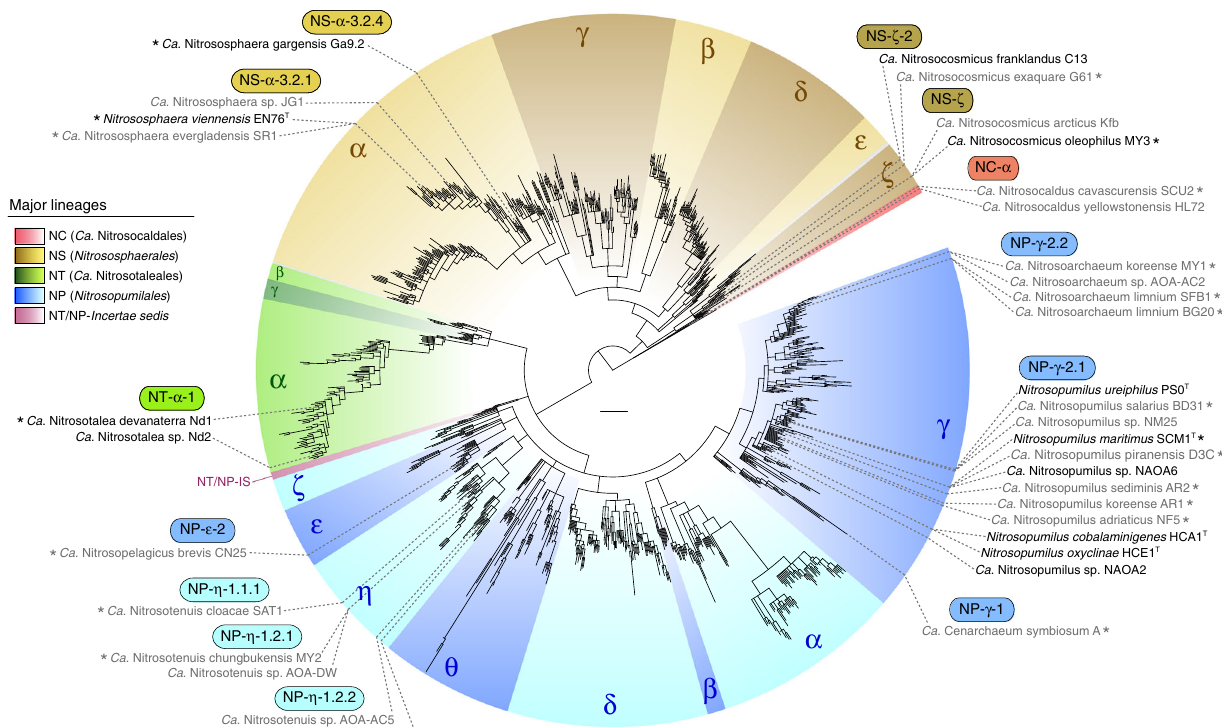
Fig. 1 Global phylogeny of archaeal amoA genes from cultivated and environmental AOA. The phylogenetic tree was inferred from 1190 amoA sequences (591 aligned positions) representing 33,256 sequences in the curated database clustered at 96% sequence identity, after extensive phylogenetic analyses (see Supplementary Fig. 1). Order-level lineages are indicated by fi ve main different colours, and major constituent subclades are indicated by Greek letters and different shades. Strains in pure or enrichment culture are indicated in black and grey text, respectively, and their abbreviated amoA -based classi fi cation is indicated in coloured boxes. Asterisks indicate organisms with sequenced genomes. The tree was inferred by maximum likelihood with IQ- TREE 80 using a GTR + F + I + Γ 4 model, and branch support values were calculated from 1000 replicates. All branches shown have ultrafast bootstrap 37 ≥ 95% and SH-aLRT 38 ≥ 85%, each threshold corresponding to an estimated con fi dence level of 95% 37 ; branches with lower support were collapsed and branch lengths were re-calculated with the GTR + F + I + Γ 4 model. The scale bar represents 0.1 substitutions per nucleotide position. All clades were strictly de fi ned based on the fi nal tree topology according to the aforementioned criteria. Some original strain names were corrected to comply with International Code of Nomenclature of Prokaryotes, according to Kerou et al. 13 (see also Supplementary Table